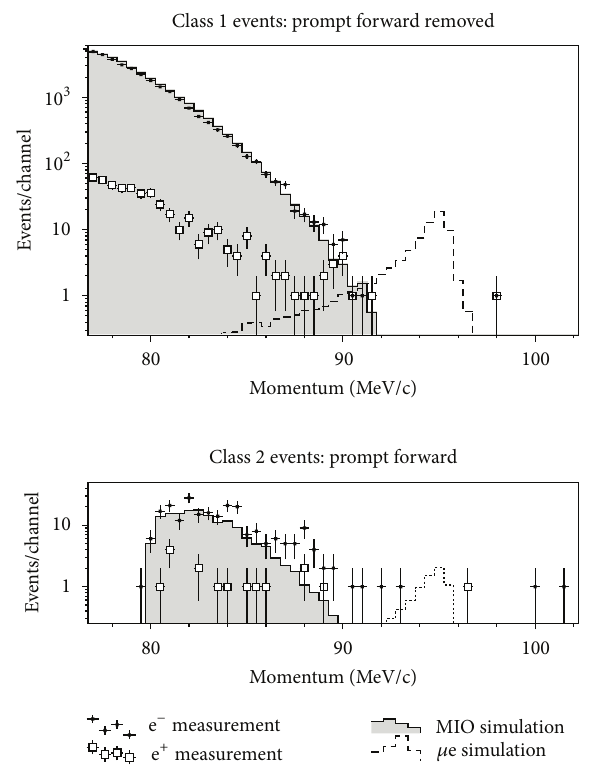
Figure 24: Momentum distribution of electrons and positrons measuredbySINDRUMIIspectrometerforAutarget(adaptedfrom